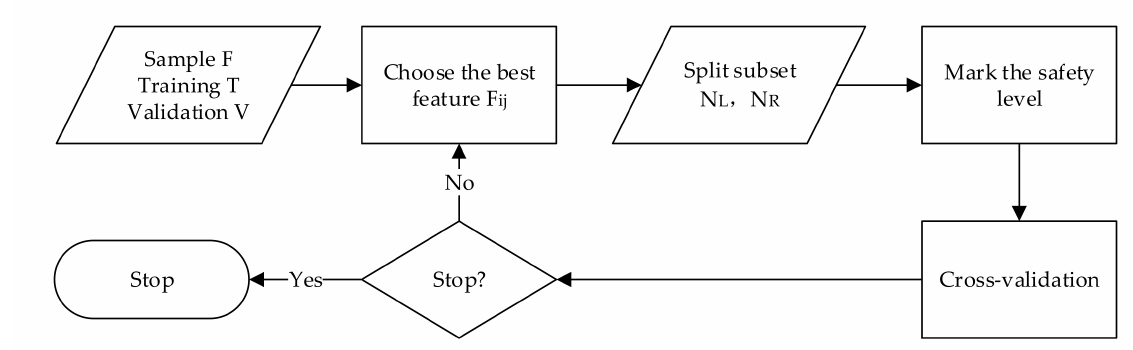
Figure 6. Decision tree training algorithm process.